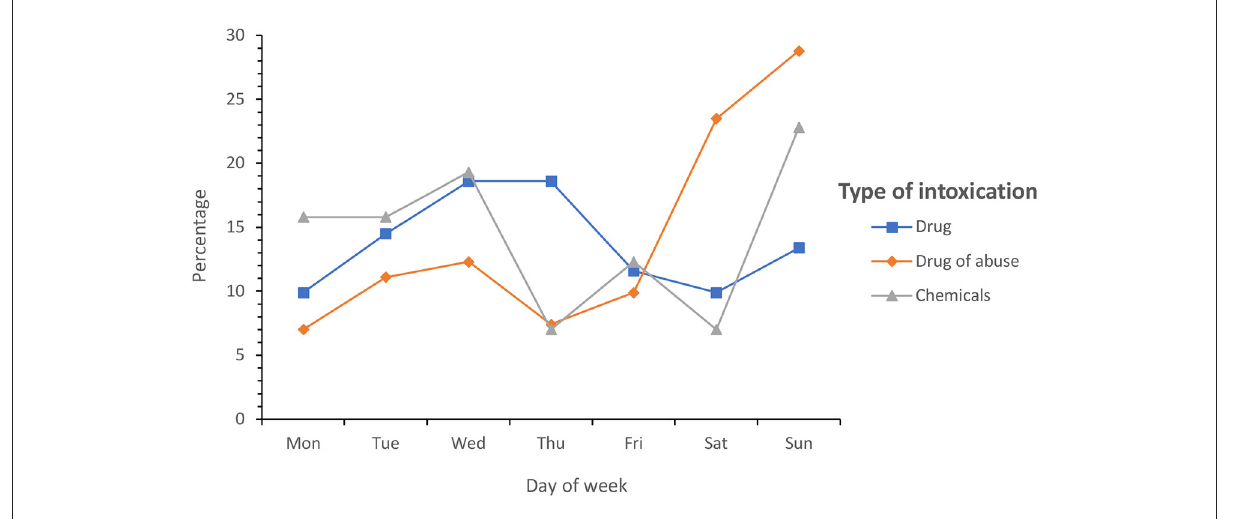
FIGURE3 Percentage of cases by type of intoxication and day of the week.